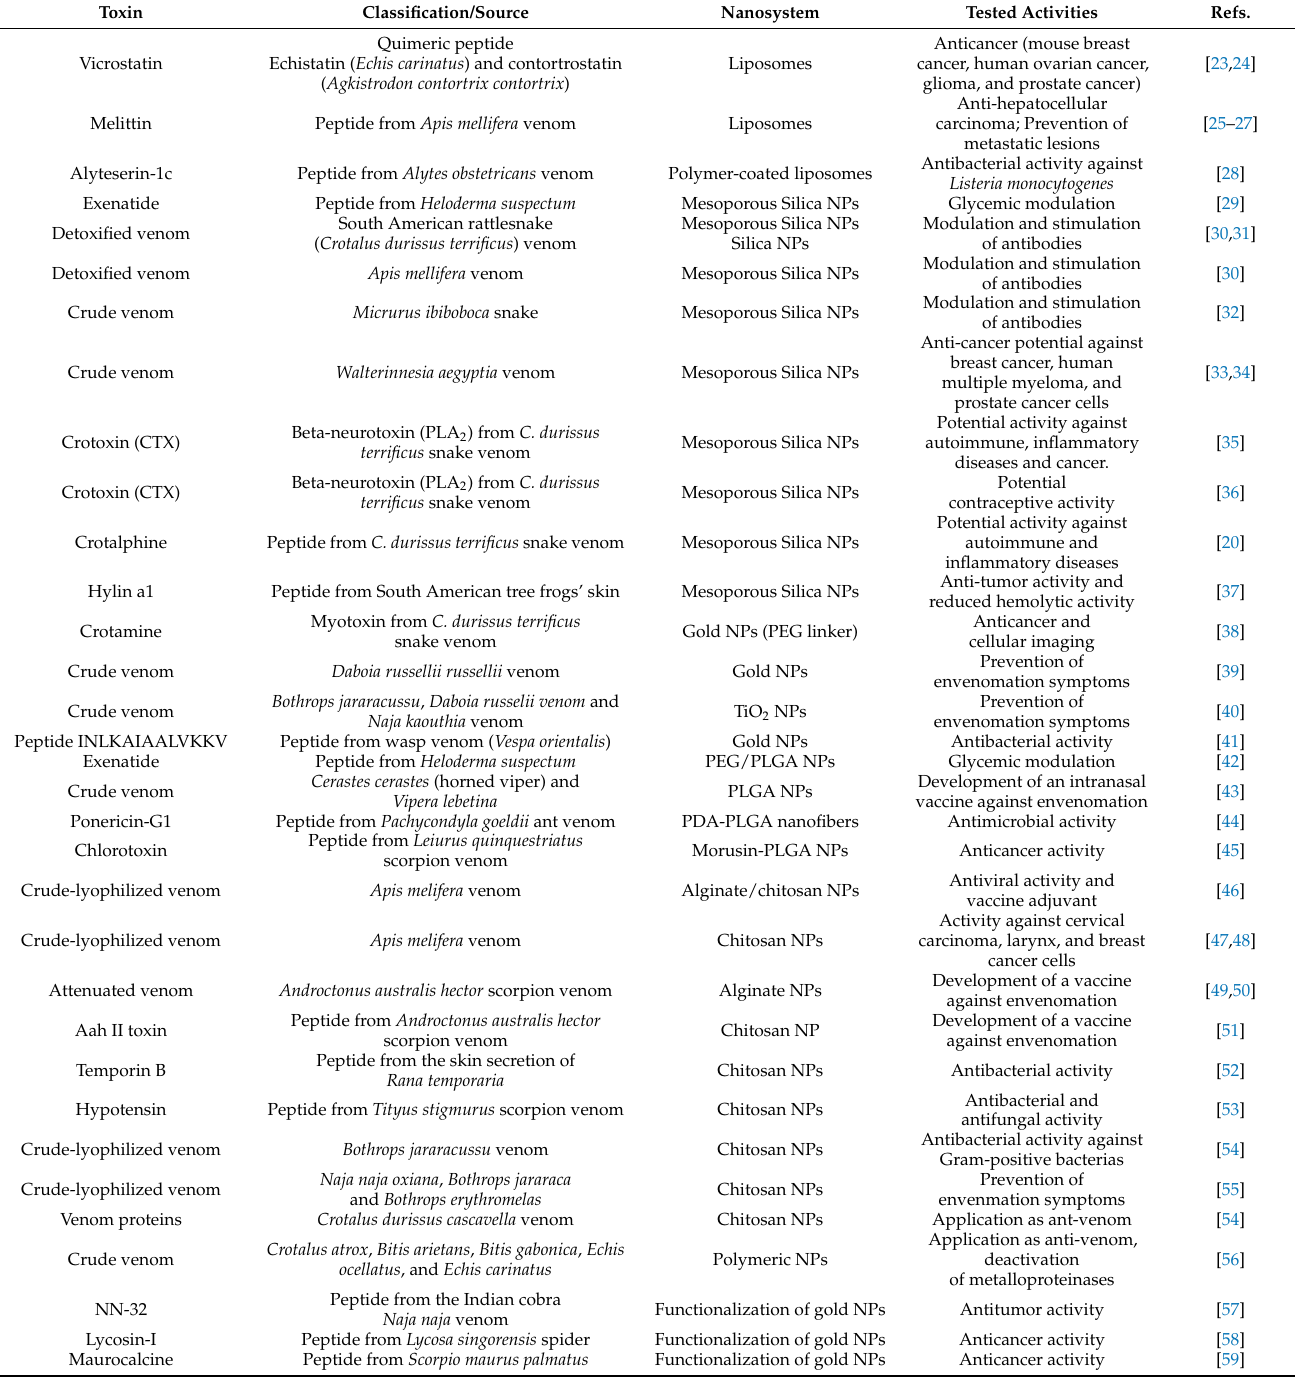
Table 1. Animal toxins and nanotechnology: biomacromolecules, sources, nanosystems, and